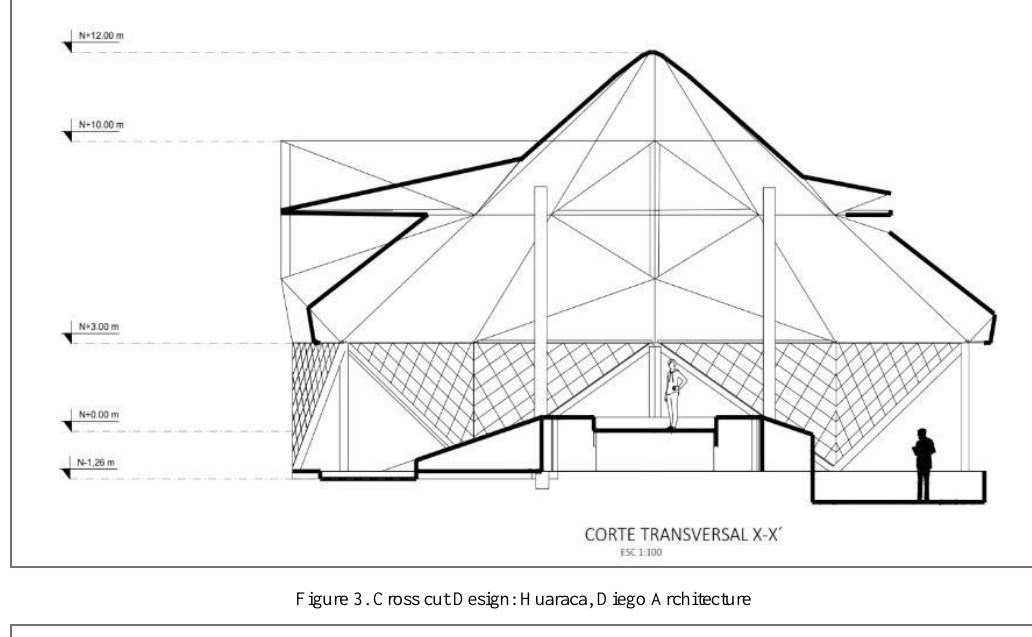
Figure 3. Cross cut Design: Huaraca, Diego Architecture